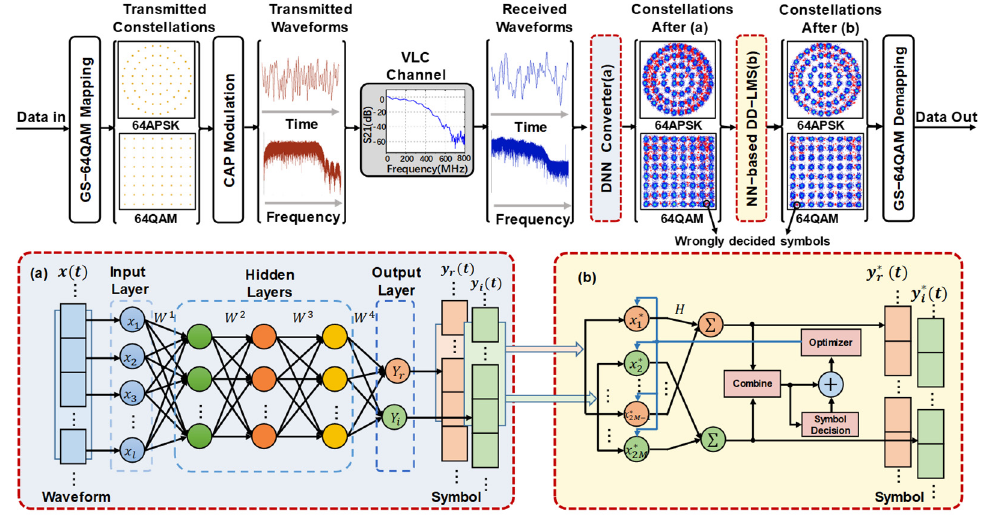
Figure 1. The schematic diagram of the UVLC system using the cascaded receiver. ( a ) shows the details of the front-stage DNN-based waveform-to-symbol converter at the front stage. ( b ) shows the details of the modified NN-based DD-LMS at the rear stage.